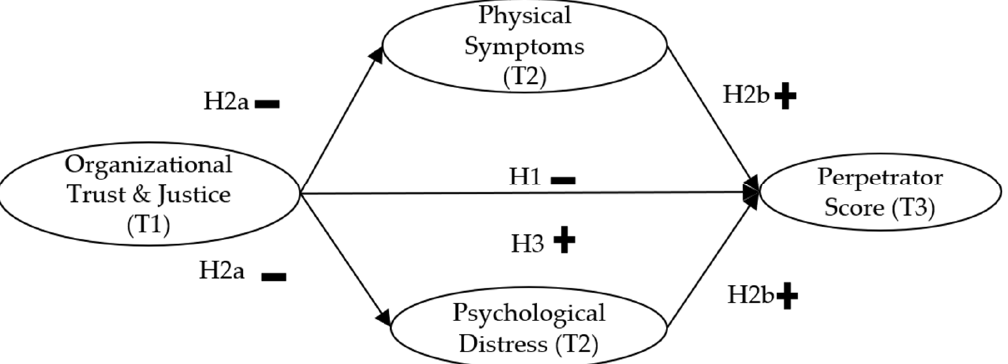
Figure 1. Overview of hypothesized relationships in the